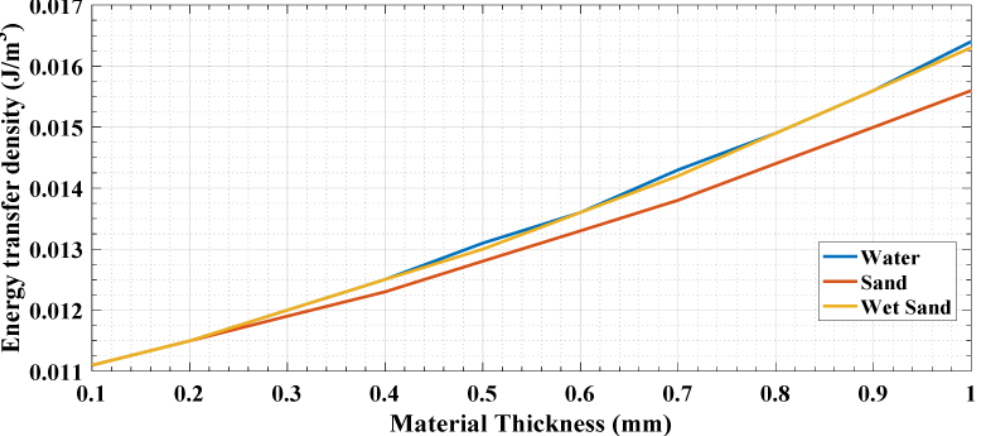
Figure 24. Variation of energy transfer density with respect to material